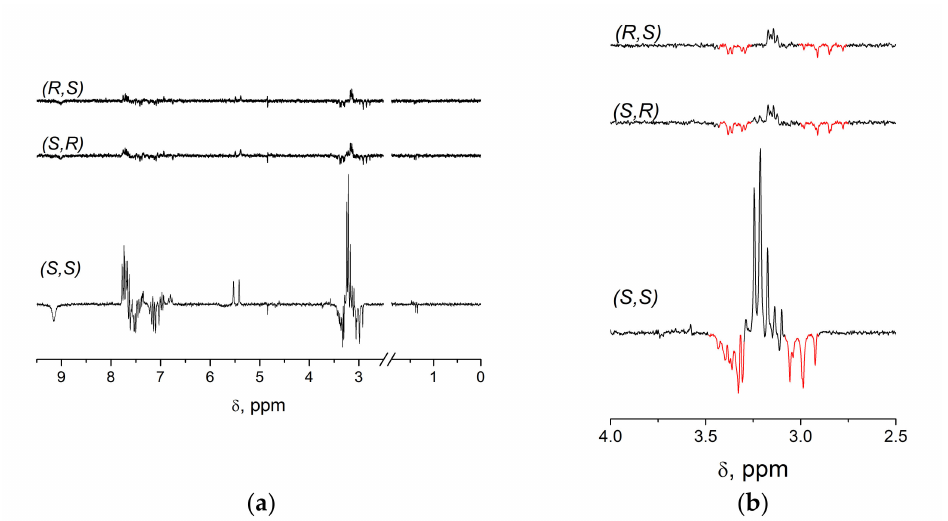
Figure 2. ( a ) CIDNP spectra of (R,S) -, (S,R) -, and (S,S) -configurations of the KP-Trp dyad in acetonitrile-d 3 ; ( b ) the expanded region of methylene protons of the Trp fragment; red colored lines are byproducts of partial degradation of the Trp fragment of the dyad (see details in Supplementary Figures S5 and